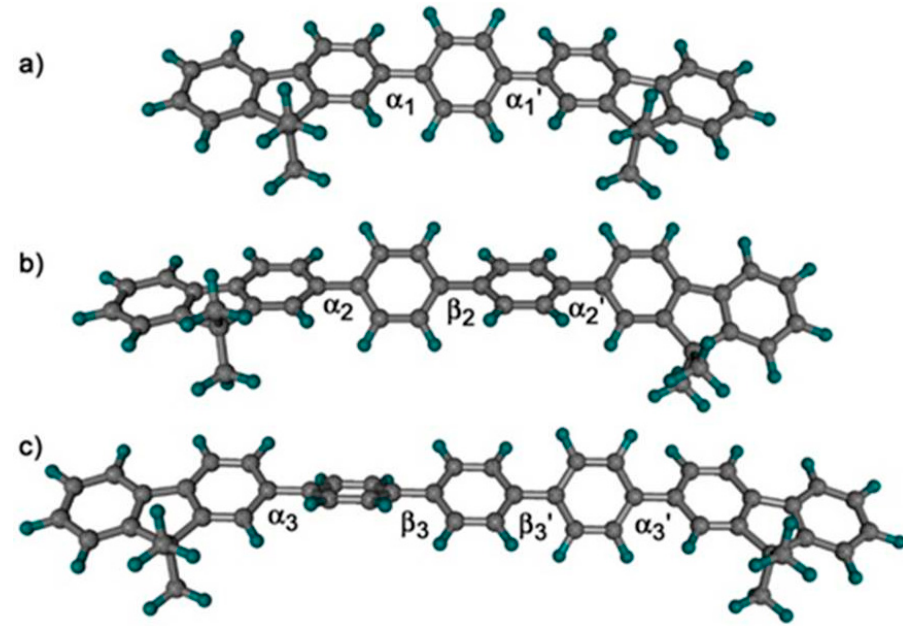
Figure 3. B3LYP/6311-G(d,p) optimized geometries of structural models of ( a ) PBS-PFP; ( b ) PBS-PFP2; and ( c ) PBS-PFP3. The phenoxybutylsulfonate chains at position 9 of the five-membered